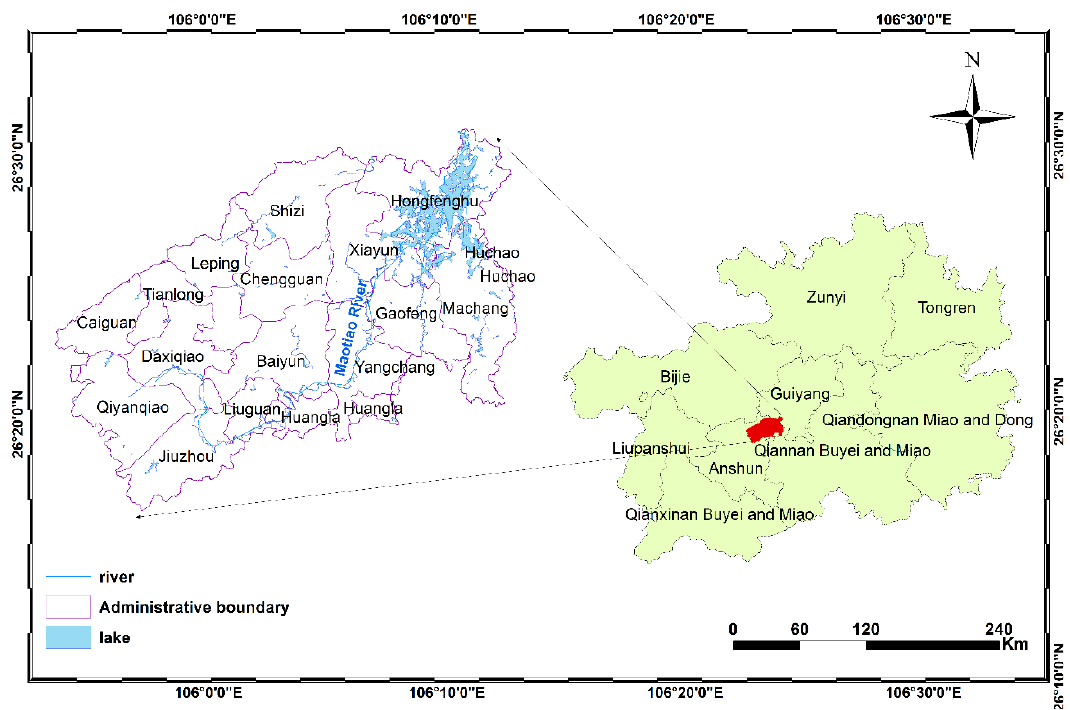
Figure 1. Location of Hongfenghu reservoir watershed in the Guiyang and Anshun Cities of Guizhou Province, China.